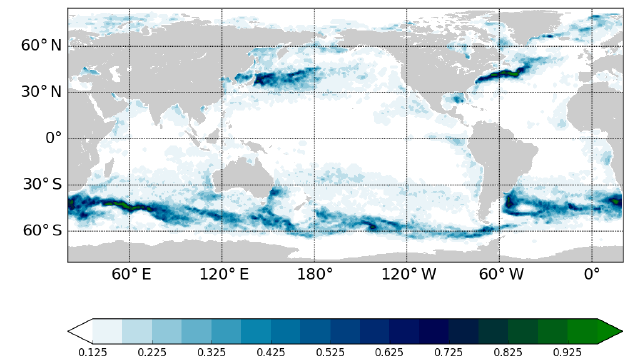
Figure 19. Ensemble spread of ORAS5 SST (K) estimated using five ensemble members of ORAS5, computed using the monthly- mean SST anomaly in